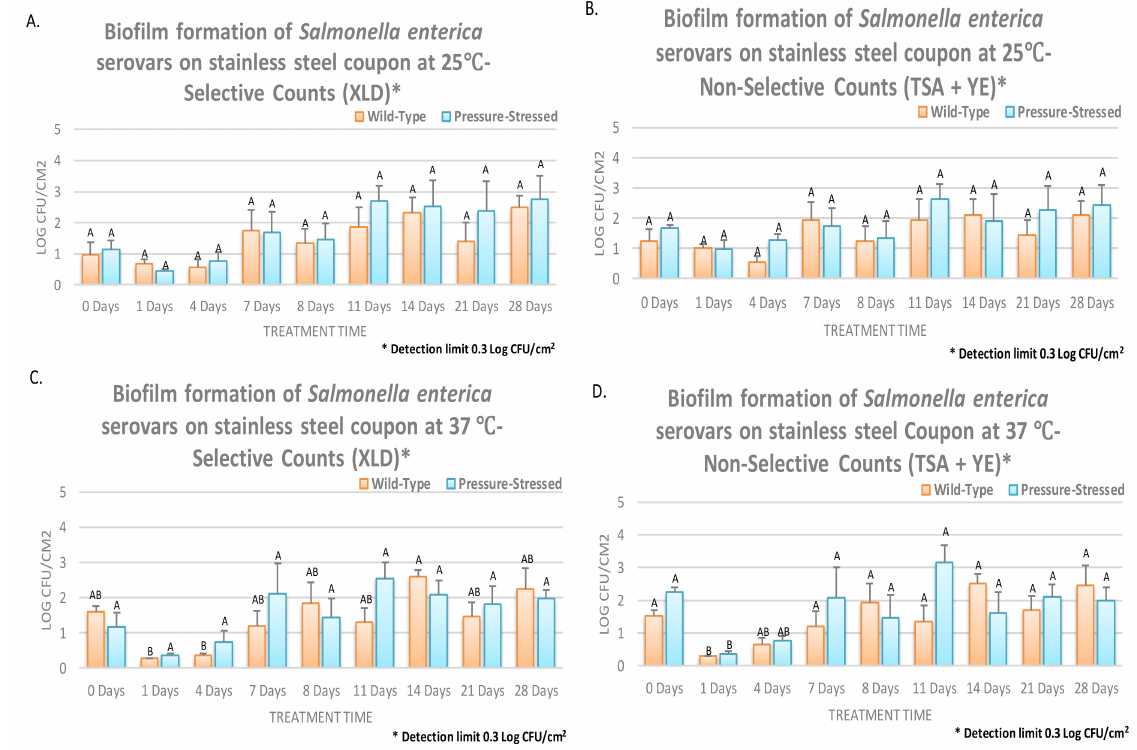
Figure 4. Survival and biofilm formation of five-strain cocktail of Salmonella serovars (ATCC ® numbers 13076, 8387, 6962, 9270, 14028), wild-type, and treated by elevated hydrostatic pressure (pressure-stressed) at 15,000 PSI (Barocycler Hub880, Pressure BioScience Inc., South Easton, MA, USA) for 15 min on stainless steel coupons in autoclaved Cumberland river water for 0, 1, 4, 7, 8, 11, 14, 21, and 28 days at 25 and 37 ◦ C. In each graph, each column of each time interval is representing log CFU / cm 2 . The detection limit on both selective (XLD) and non-selective (TSA + YE) media was 0.3 log CFU / cm 2 . ( A ) Survival of biofilm mass on XLD at 25 °C; ( B ) Survival of biofilm mass on TSA + YE at 25 ◦ C; ( C ) Survival of biofilm mass on XLD at 37 ◦ C; ( D ) Survival of biofilm mass on TSA + YE at 37